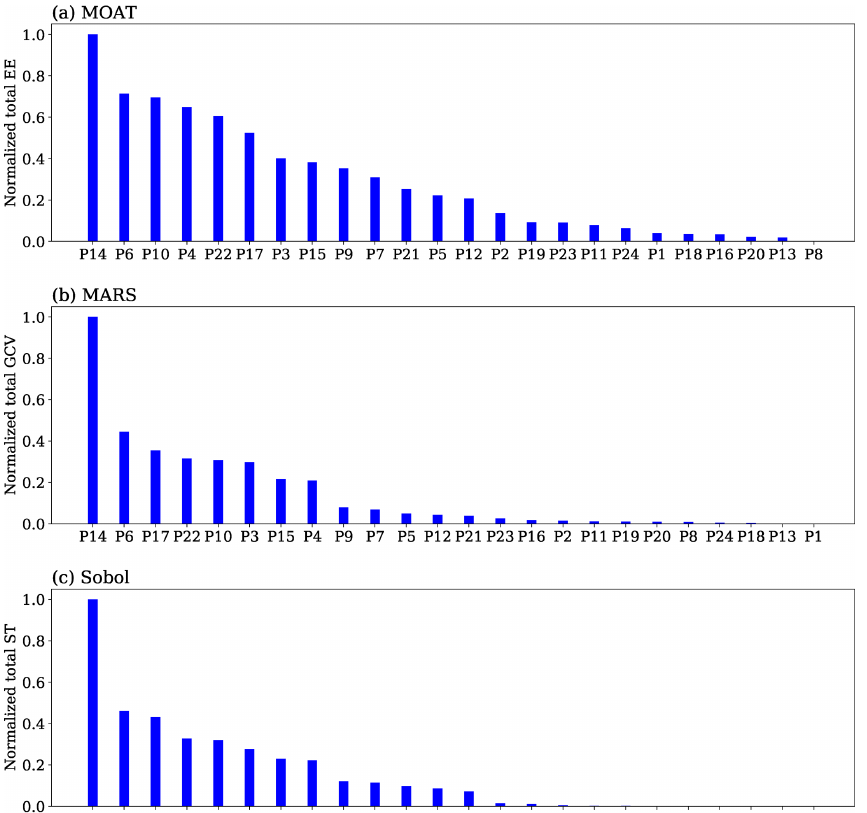
Figure 13. Ranks of the parameters according to their sensitivities based on (a) MOAT method, (b) MARS method, and (c) Sobol’